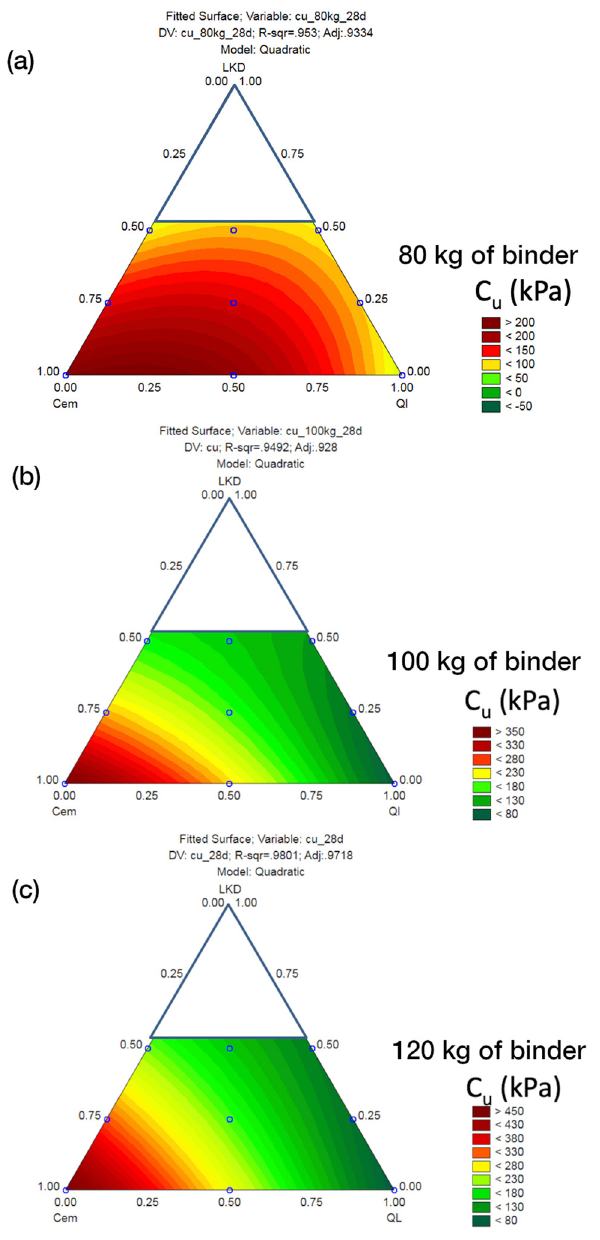
Figure 4: Response surface showing shear strength after 28 days of curing at 7 °C with varied amount of binders. ( a ) 80 kg m 3 / , ( b ) 100 kg m 3 / , ( c ) 120 kg m 3 / .